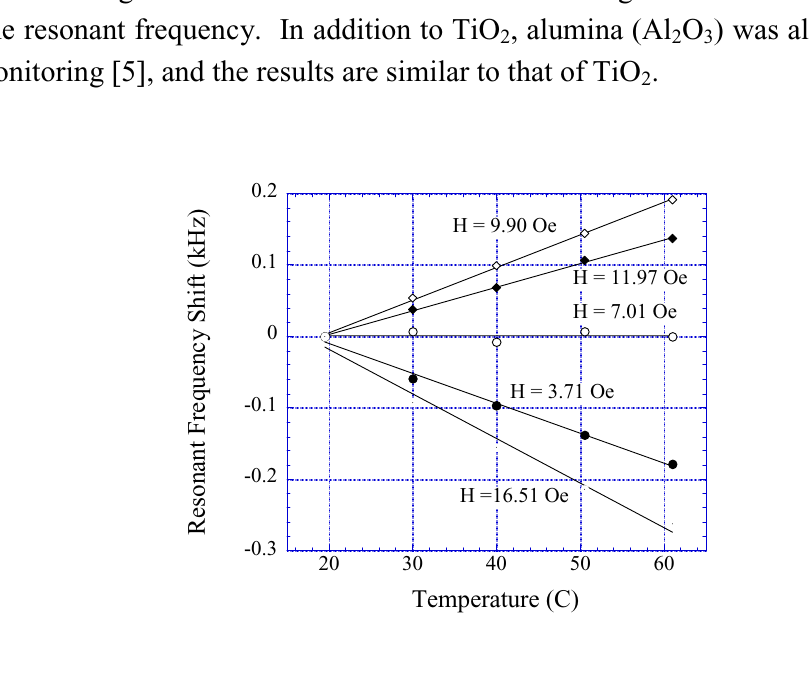
Figure 9. The resonant frequency shifts of a magnetoelastic sensor verses temperature and bias field H . The highest positive temperature dependency happens at H = 9.9 Oe, highest negative temperature dependency at H =16.51 Oe, and zero-temperature dependency at H = 7.01 Oe.